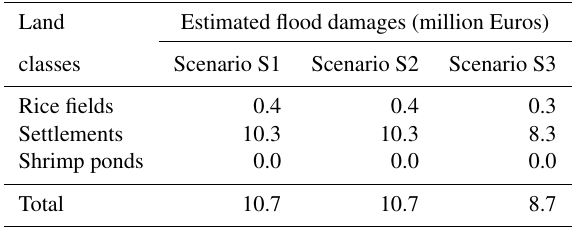
Figure 9. Comparison of flooded areas corresponding to different scenarios considering the breaching in the central part of the sea- facing dike.